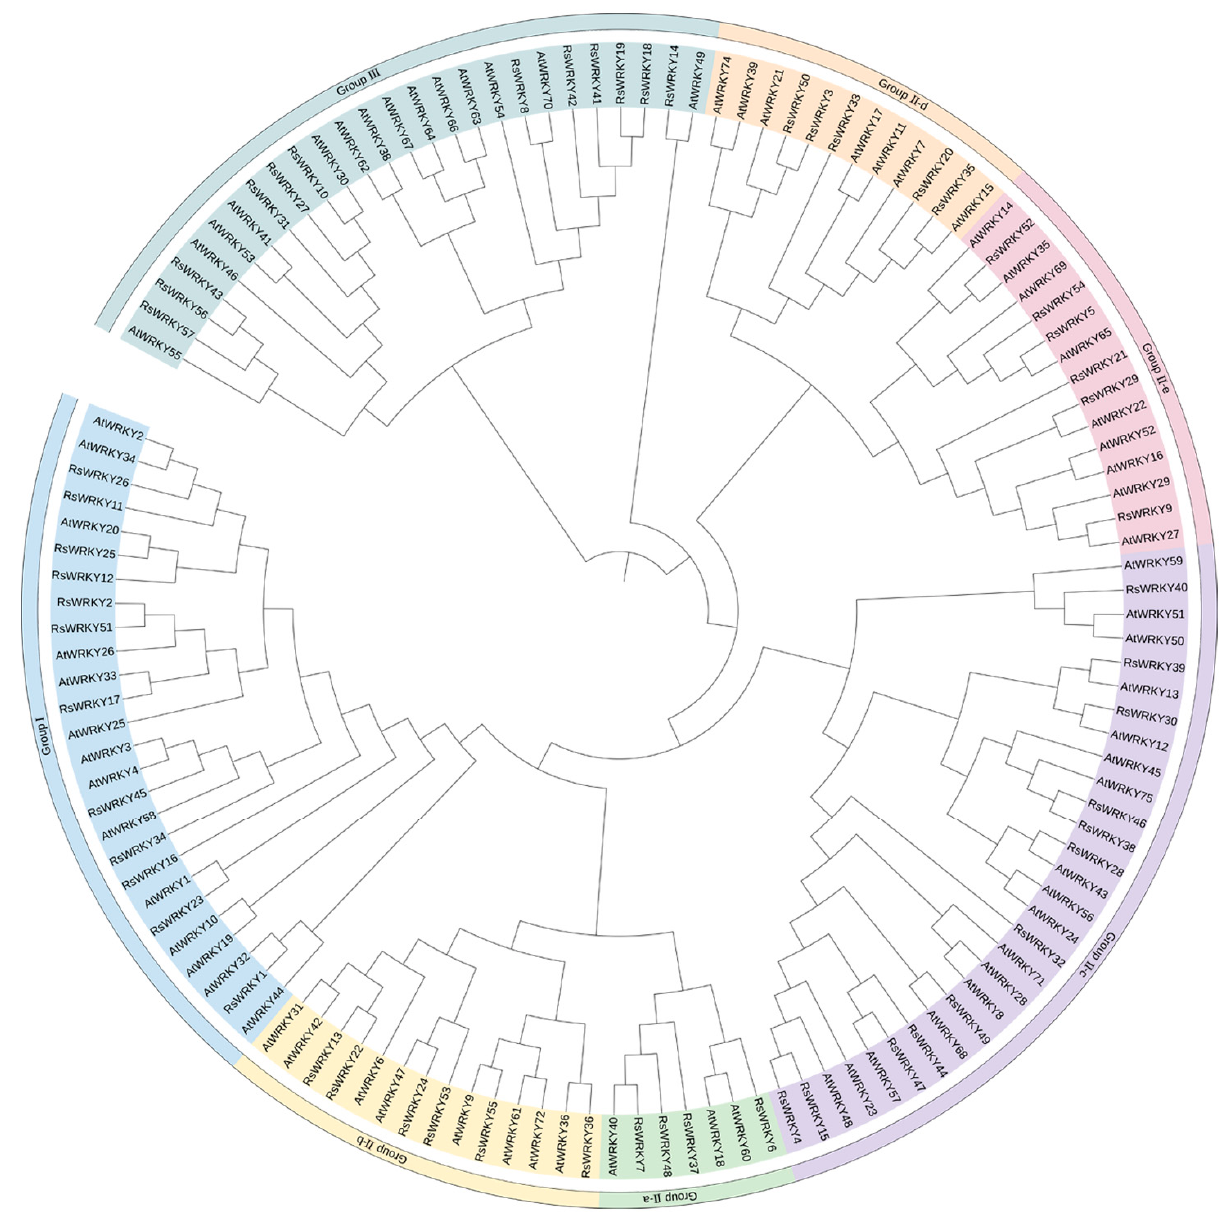
Figure 2. Phylogenetic analysis among the identified WRKY-conserved proteins in A. thaliana and R. simsii . The 72 A. thaliana and 57 R. simsii WRKY sequences were aligned using Muscle; the phylogenetic tree was constructed by MEGA6.0 with the maximum likelihood method, and the bootstrap value was set at 1000 repetitions. The colorful regions represent different subfamilies.